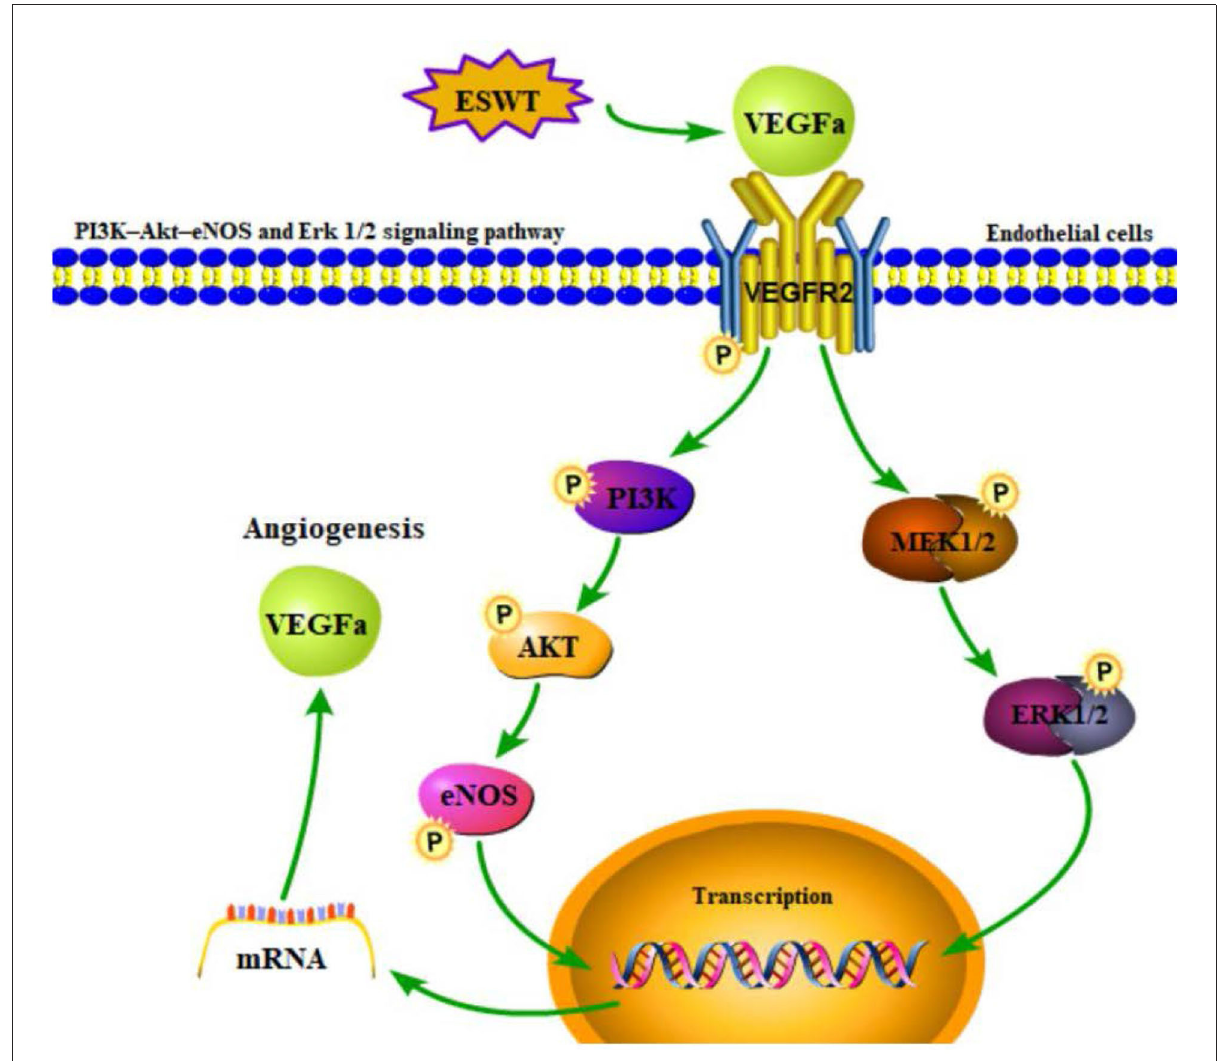
FIGURE4 PI3K-AKT-eNOS and ERK 1/2 signaling pathway induced by ESWT could promote angiogenesis through endothelial cells migration.